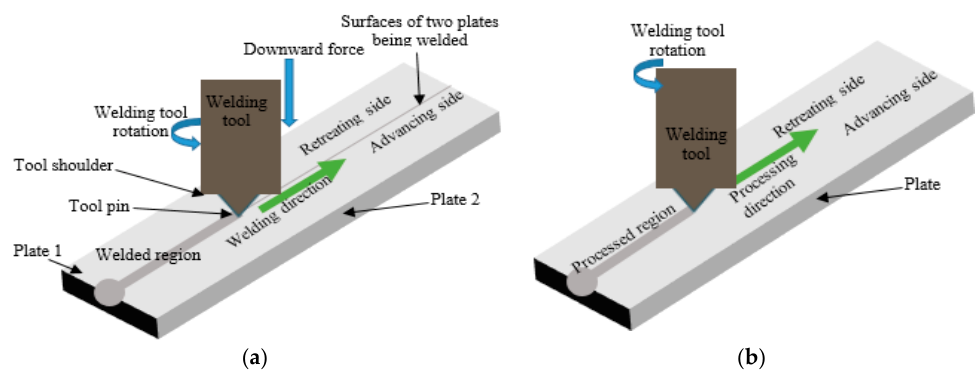
Figure 1. ( a ) FSW (friction stir welding) and ( b ) FSP (Friction stir processing) technique.